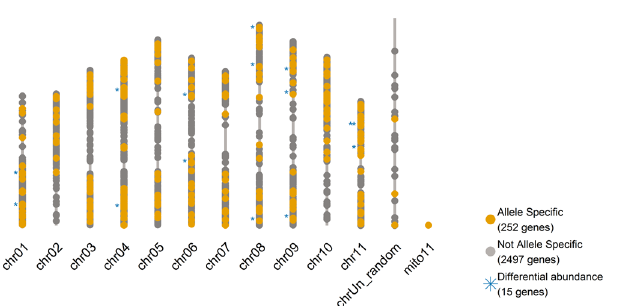
Figure 4. All identified gene loci, indicated when evidence (SAAP) for cultivar specificity was found. Differential peptide abundance between control (0% PEG) and osmotic stress (5% PEG) was assessed using the Kruskal Wallis test ( α = 0.1) in the ABB and AAA cultivars using 3 or 6 biological replicates